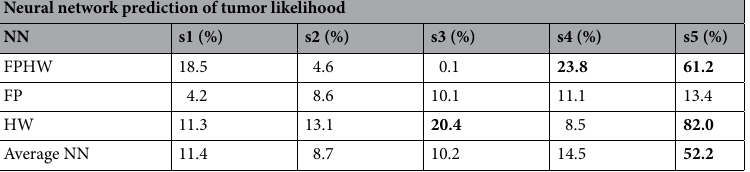
Tumor probabilities produced by the NNs trained using k-means spectral classification were compared to the predictions by NNs trained using histopathology classification as the gold standard. The results appear in Fig. 3. Spectra were obtained from regions classified by histopathology as likely to be composed of either 100% tumor or 0% tumor. Networks were trained using as inputs (x) 6 bands from the FP region (FP); ( △ ) 3 bands from the HW region (HW); or ( ) the full set of 9 bands (FPHW). Targets obtained from tissue in tumor-rich region according to H&E stain are denoted by red markers, while data obtained from areas apparently devoid ● of tumor are denoted by blue markers. This analysis is repeated with balanced classes (Healthy, Tumor, n = 25) in Supplementary materials (See Supplementary Fig. S1). The k-means clustering and human expert histopathology classification of 100% and 0% tumor regions disa- greed on five (5) spectra. Table 4 shows the NN (trained on k-means) generated probabilities for these 5 spectra